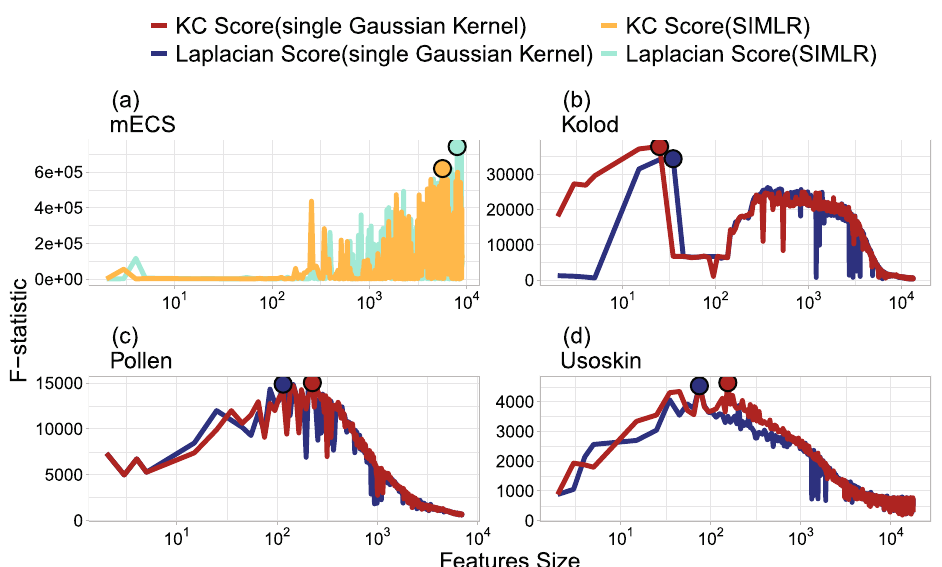
Figure 6. The MANOVA Pillai’s Trace statistic curves of Strategy A against different numbers (log scale) of genes based on the KC Score (single Gaussian kernel; SIMLR) versus Laplacian Score (single Gaussian kernel; SIMLR) for the four scRNA-seq datasets, where the circles denote the locations of the k 1 ’s for each method.